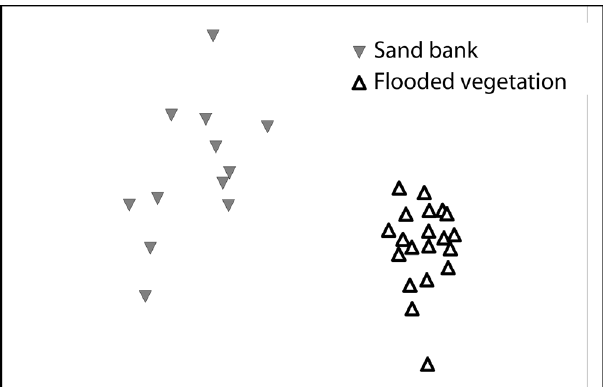
Fig. 2. Non-multi-dimensional scaling (MDS) ordination depicting similarity/dissimilarity of fish assemblages from flooded vegetation (open triangles) and sand bank habitats (inverted closed triangles). Each symbol represents one sam- pling site. Relative distance among symbols represents the relative similarity/dissimilarity of assemblage composition from the site based on presence/absence